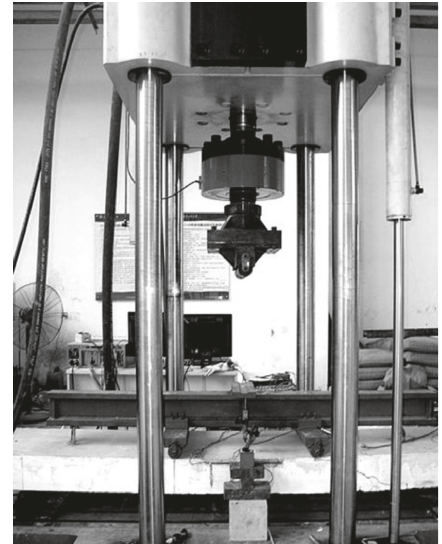
Figure 2: Practicality picture of the test. Table 2: Mechanical properties of HRB335 and 1.4362 duplex stainless